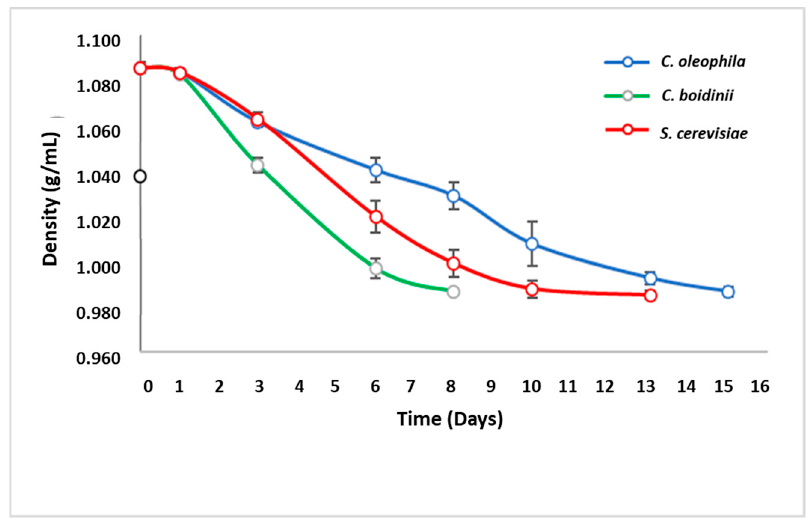
Figure 3 . Evolution of substrate consumption through the measurement of density in sequential fermentations (Sauvignon Blanc).